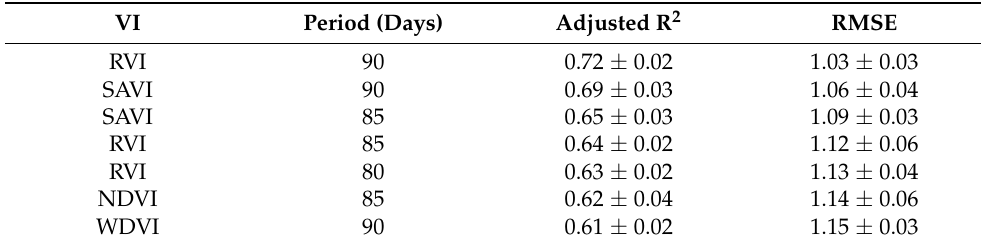
Table 8. The 10 best-performing vegetation indices and